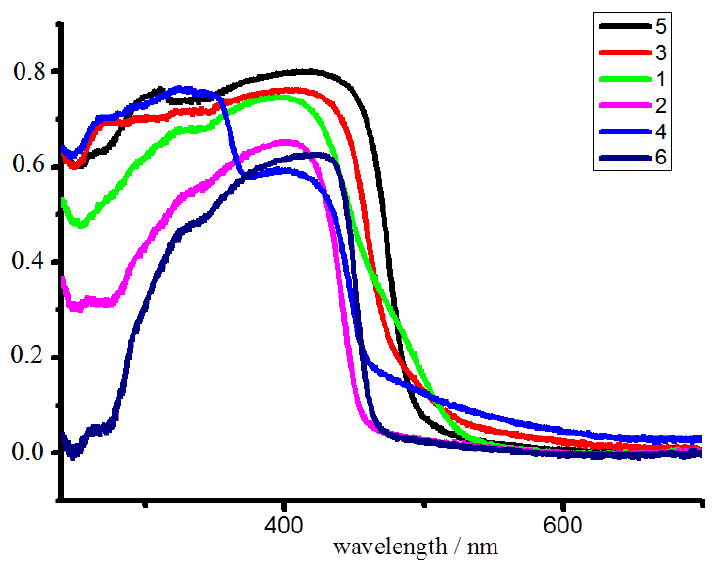
Figure 2. Reflectance spectra of 1–6.